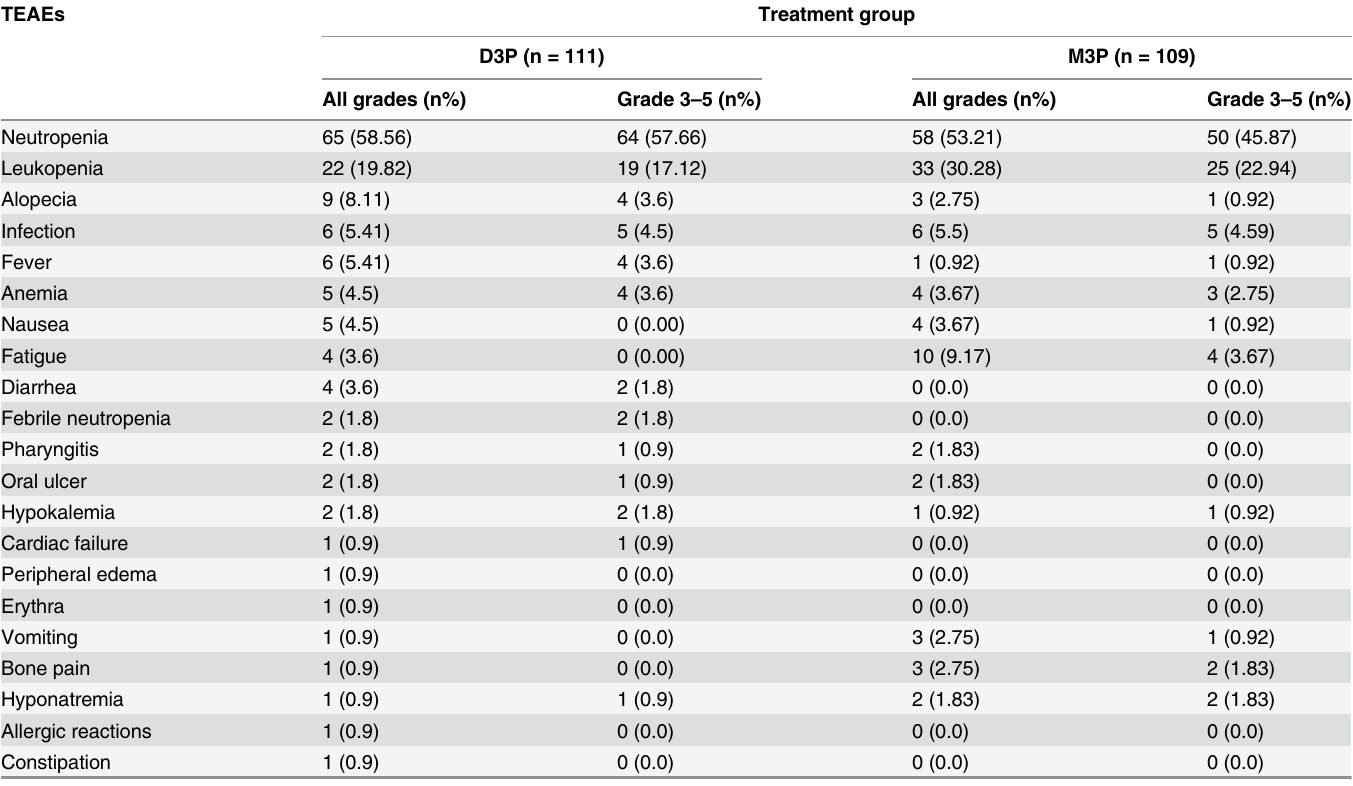
Table 4. A summary of the incidence of TEAEs in the safety population.